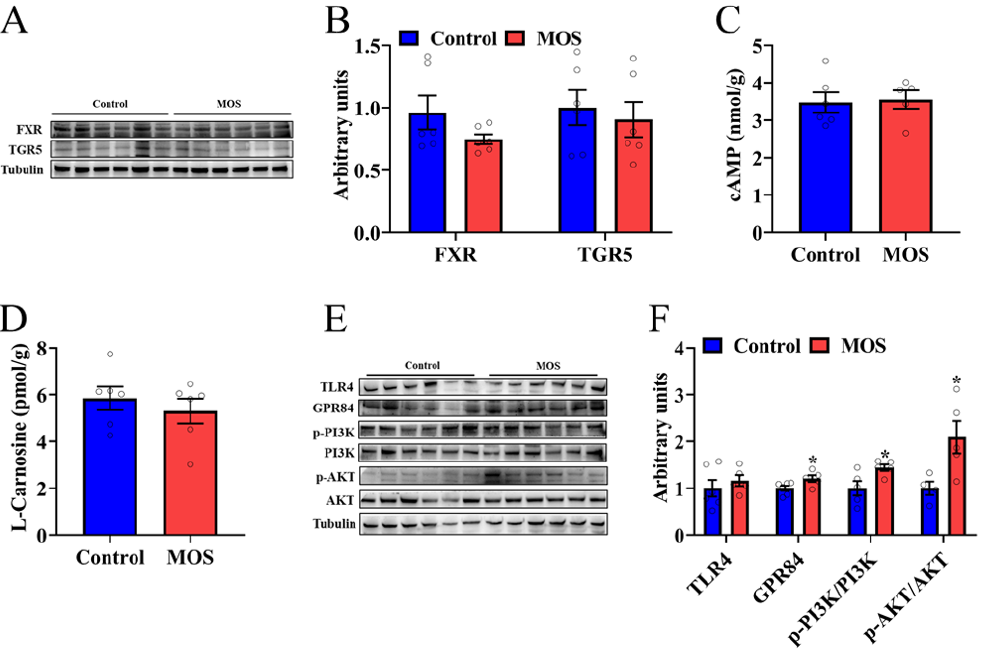
Figure 4. Decanoic acid may be the key metabolite that mediates the effects of mannan oligosaccha- rides on skeletal muscle. ( A , B ) The protein expression level of FXR and TGR5 in the GAS. ( C , D ) cAMP and L-carnosine concentrations in the GAS. ( E , F ) The protein expression level of TLR4, GPR84 and PI3K/AKT signaling pathways in the GAS. * p < 0.05 versus the control group.